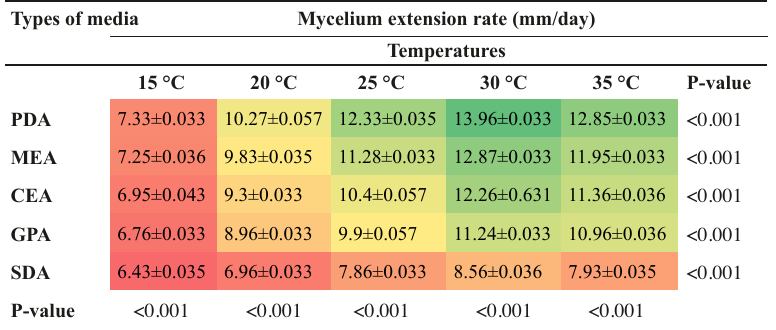
Tab. 1: Mycelial growth rate (mm/day) of M. gigantea on different media at different temperatures. CEA, Compost Extract Agar; PDA, Potato dextrose agar; MEA, Malt Extract Agar; SDA, Saboraud Dextrose Agar; GPA Glucose Peptone